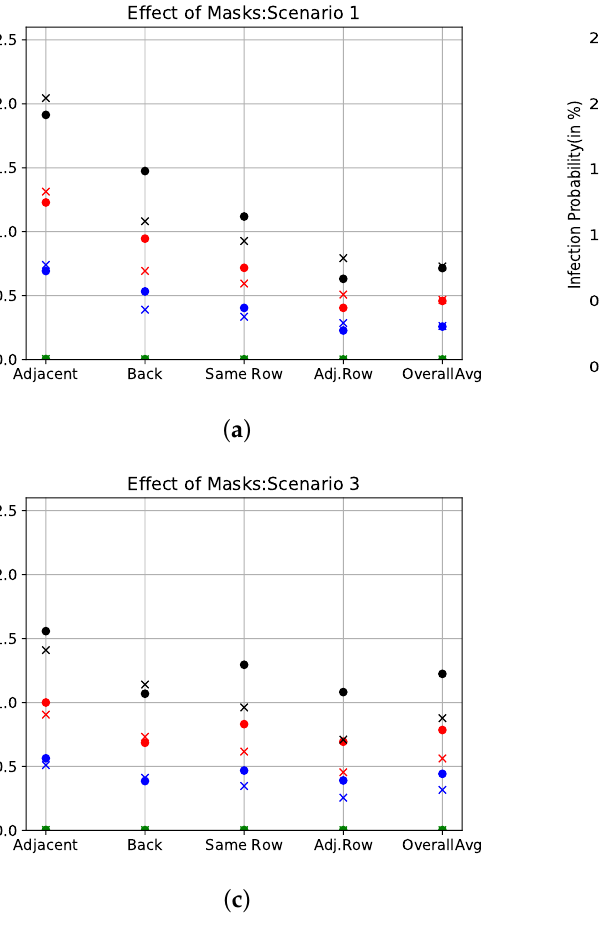
Figure 9. Effect of wearing a mask of different efficiencies for ( a ) Scenario 1, ( b ) Scenario 2, ( c ) Scenario 3, ( d ) Scenario 4. The keys in the legend with prefix ’S’ and ’L’ refer to AP placed on the short side and long side of the room, respectively. The suffixes ’NM’, ’C’, ’S’, and ’N95’ refer to cases with no mask, cloth masks, surgical masks, and N95 masks,